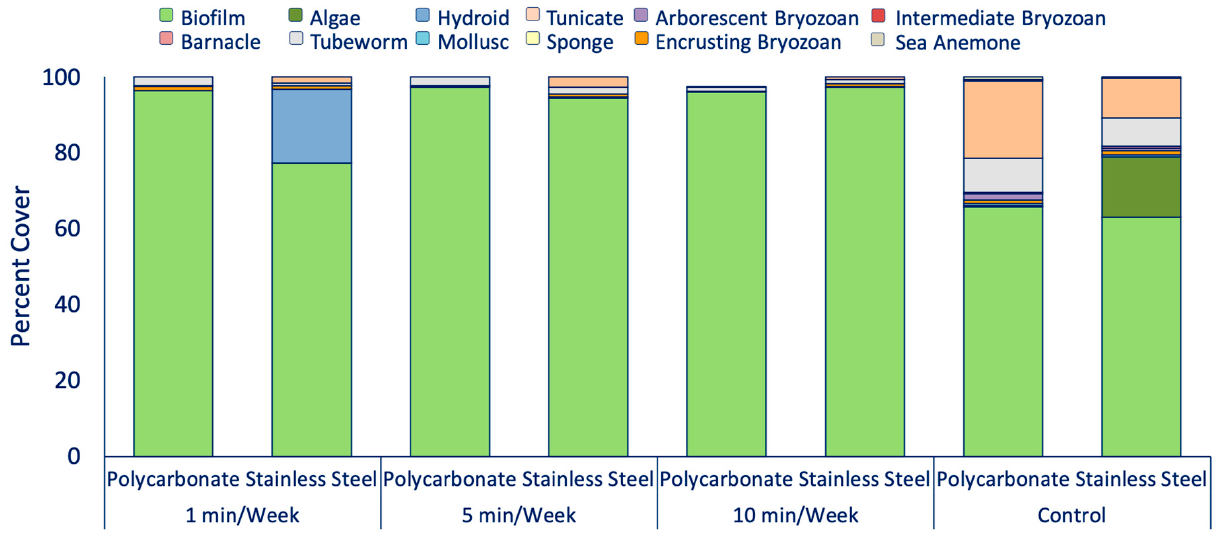
Figure 6. Biofouling composition on the UVC-exposed polycarbonate and stainless steel panels and their corresponding controls.